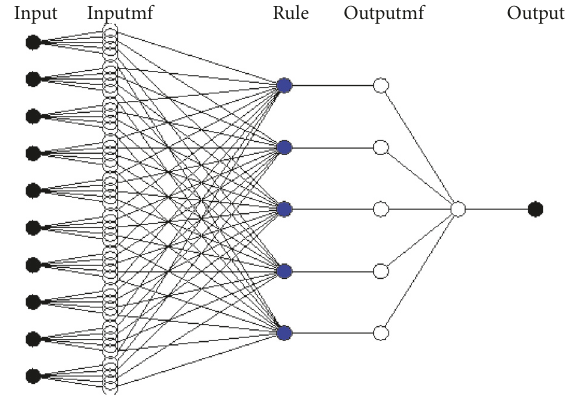
Figure 5: ANFIS estimators